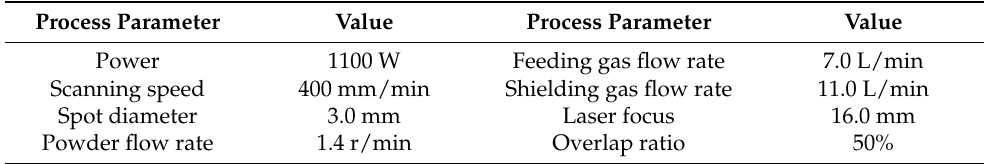
Table 3. The process parameters of the laser cladding.